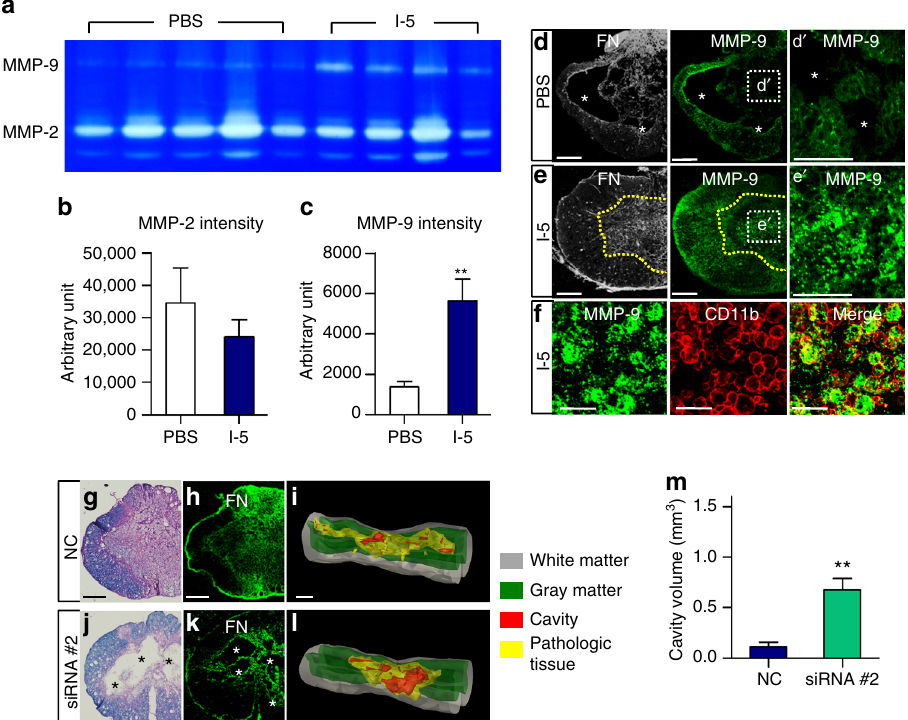
Fig. 6 MMP-9 mediates fi brotic ECM remodeling. a Gelatinase activity of MMP-9 and MMP-2 in the PBS ( N = 5) and the I-5 group ( N = 4) examined by zymography. b , c Graphs showing quanti fi cation of MMP-2 ( b ) and MMP-9 ( c ) activity. ** indicates p < 0.01 by two-tailed Student ’ s t -test. Error bars represent the SEM. d , e Representative images of transverse spinal cord sections from animals injected with either PBS ( d ) or I-5 ( e ). Asterisks indicate cystic cavities. A yellow dotted line indicates the boundary of the FN-rich matrix. The boxed regions in the middle panels were magni fi ed in d ʹ , e ʹ . Scale bars represent 100 µ m. f MMP-9 immunoreactive granules were bounded by CD11b positive membrane-like circular structures. Scale bars represent 50 µ m. g , j Representative images of transverse spinal cord sections stained with eriochrome cyanine and eosin from animals with I-5 mixed with non-targeting control siRNA (NC) ( g ) or MMP-9 siRNA ( j ). Adjacent sections were stained with antibodies against FN ( h , k ). Scale bars represent 200 μ m. i , l 3D reconstruction of the spinal cord tissue using the Neurolucida software. Scale bars represent 1 mm. Asterisks indicate cystic cavities. m Quanti fi cation graph of cavity volume. ** indicates p < 0.01 by two-tailed Student ’ s t -test. N = 5 for each group. Error bars represent the